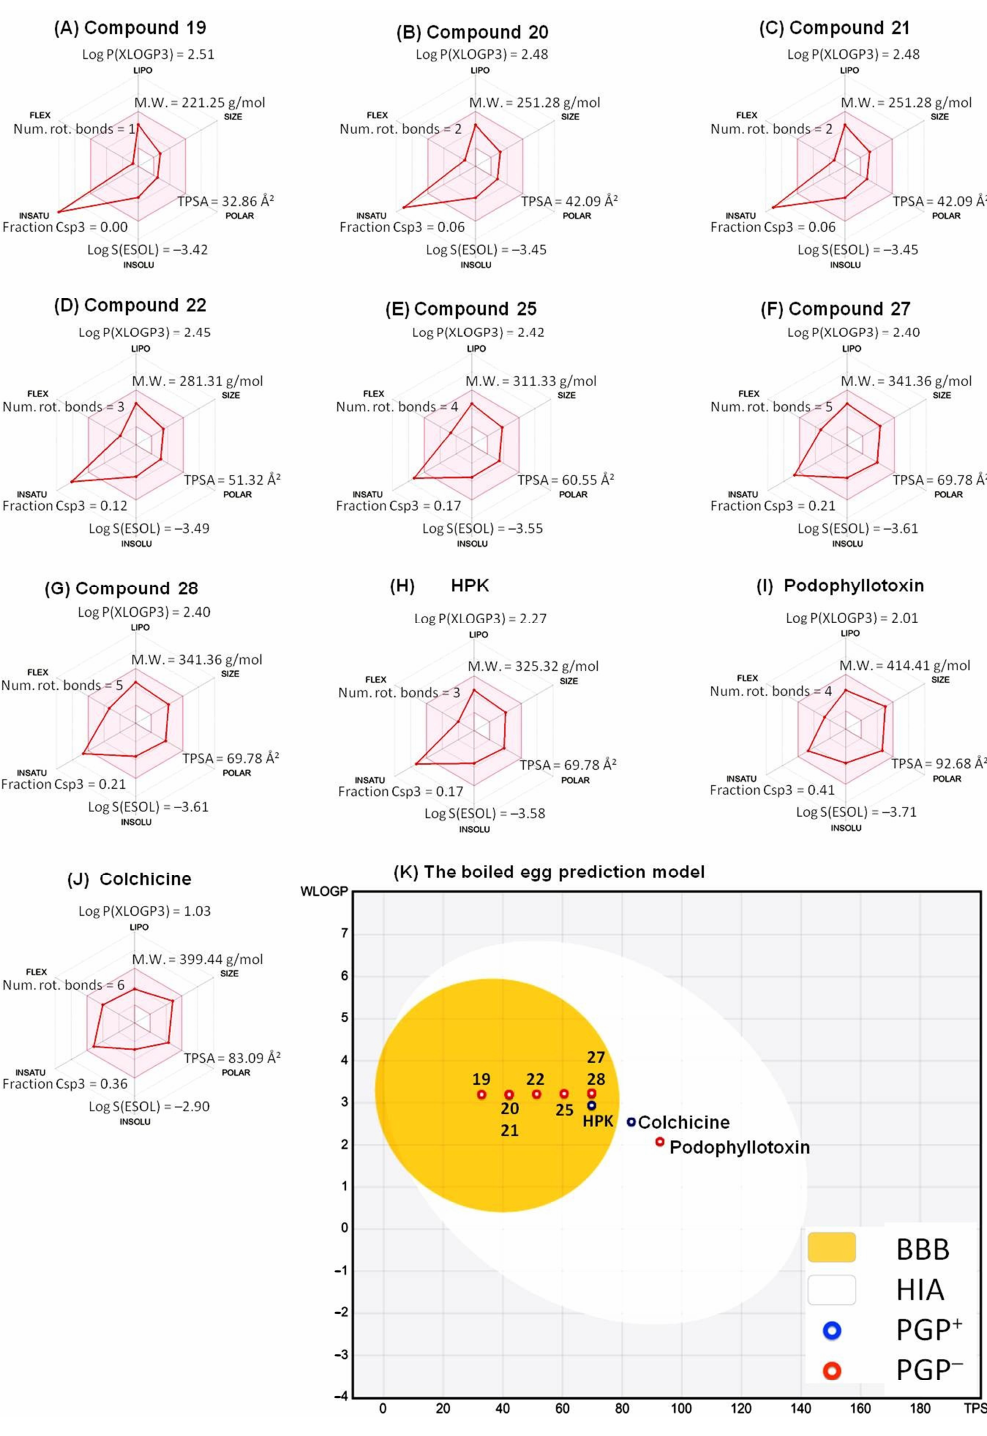
Figure 7. Bioavailability radar related to physicochemical properties of 4-PQ compounds ( A ) 19 , ( B ) 20 , ( C ) 21 , ( D ) 22 , ( E ) 25 , ( F ) 27 , ( G ) 28 , ( H ) HPK , ( I ) podophyllotoxin, and ( J ) colchicine. The bioavailability radar indicated LIPO (lipophilicity, Log P(XLOGP3)), SIZE (molecular weight), PO- LAR (polarity, topological polar surface area; TPSA), INSOLU (insolubility, Log S(ESOL)), INSATU (insaturation, fraction Csp3), and FLEX (flexibility, the number of rotatable bonds). ( K ) Graphical distribution of absorbed compounds based on bioavailability using a boiled egg prediction